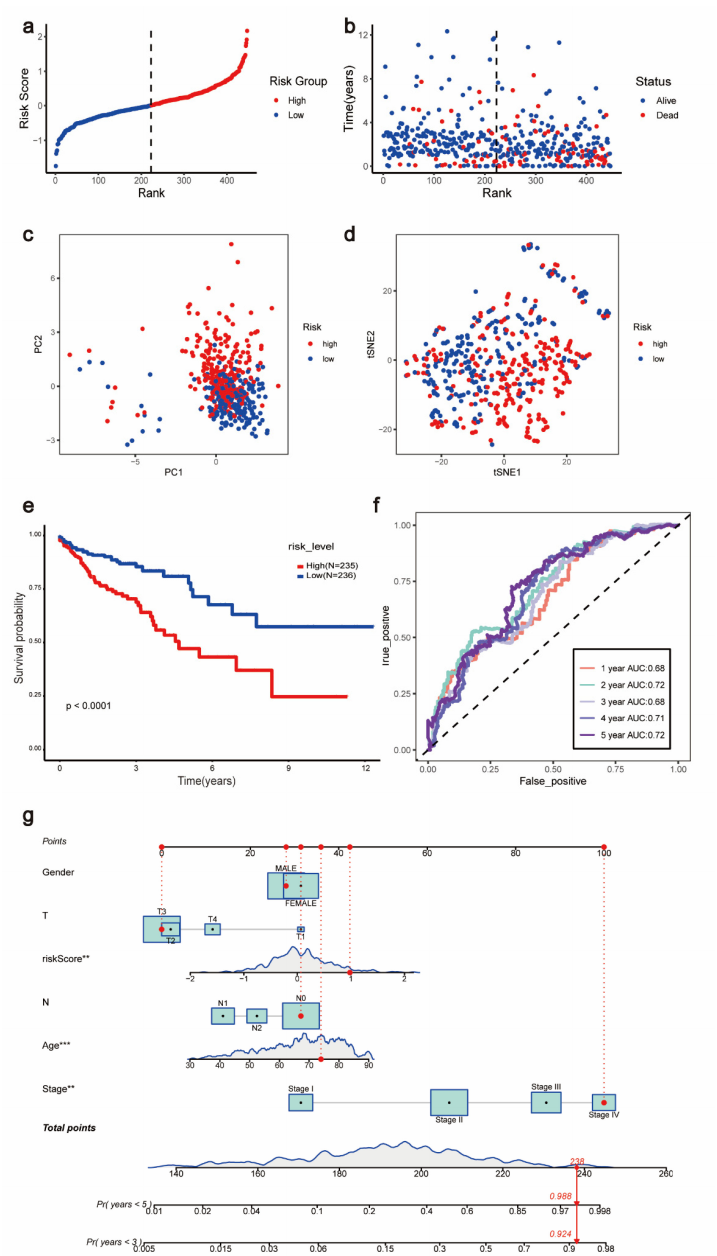
Figure 7. Validation of the prognostic model. The TCGA-COAD cohort was divided into high-risk and low-risk groups based on median risk scores. ( a ) risk curves. ( b ) risk scatter plots. ( c ) PCA. ( d ) t-SNE. ( e ) Kaplan–Meier plotter. ( f ) ROC curves. ( g ) Nomo plots. **, p < 0.01; ***, p <